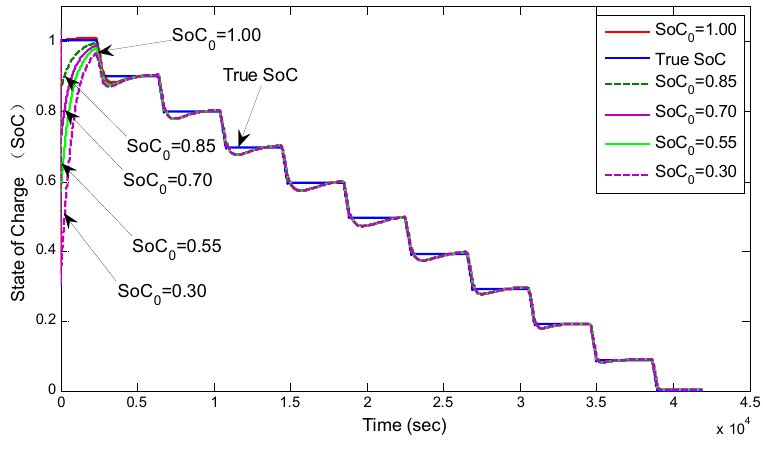
Figure 24. SOC curves for ARX(2,2) + EKF estimation with different initial SOC